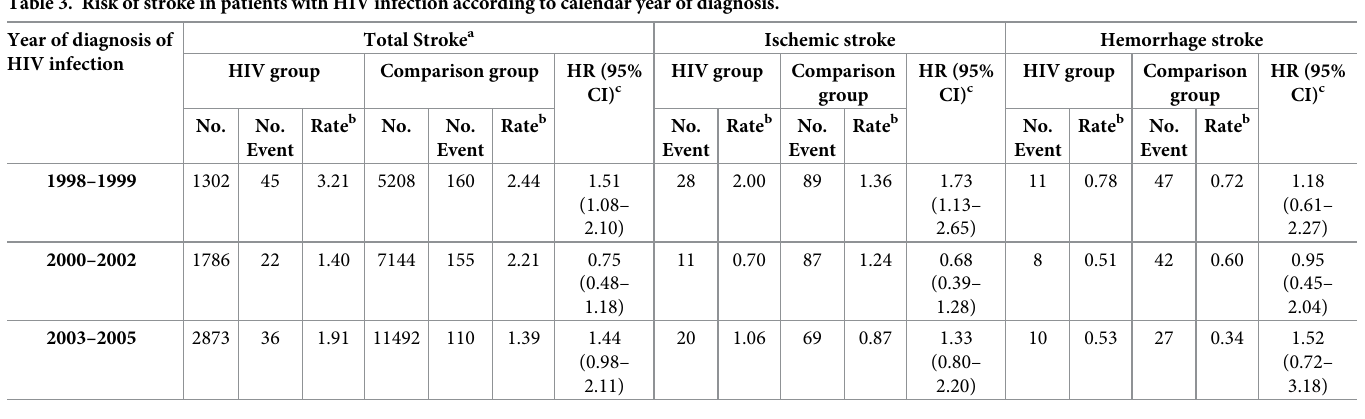
Abbreviations: No., Number CI, confidence interval; HIV, human immunodeficiency virus; HR, hazard ratio. a Patients with undetermined stroke were excluded in the analysis by stroke subtypes (n = 79). b Incidence rate per 1000 person-years. c Adjusted for age, sex, and comorbidities including diabetes, hypertension, hyperlipidemia, chronic kidney disease, cancer, coronary heart disease and atrial fibrillation. P values of test for interaction effect between HIV infection and year of diagnosis: 0.034 for total stroke, 0.056 for ischemic stroke and 0.643 for hemorrhage